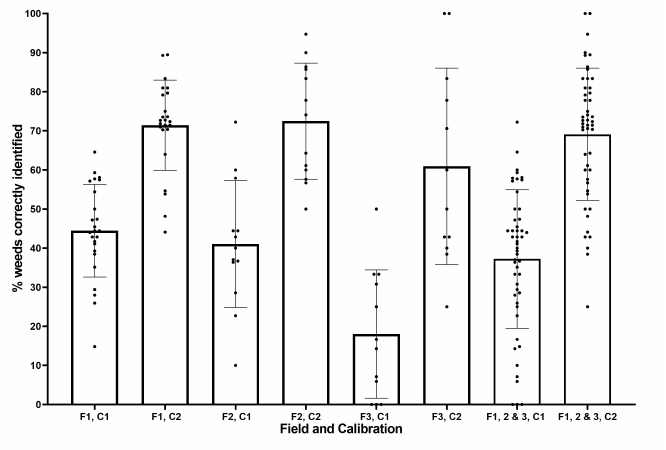
Figure 10. Proportion of weeds correctly identified for each field (F1–3) and calibration (C1,